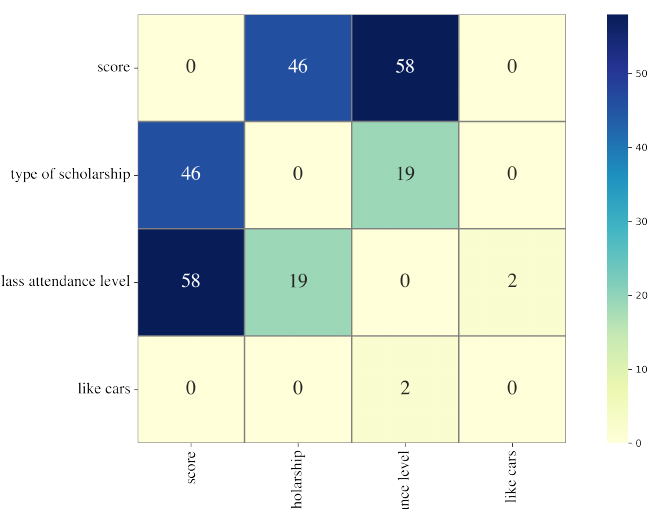
Figure 2. Associations detected in Scholarship data set.